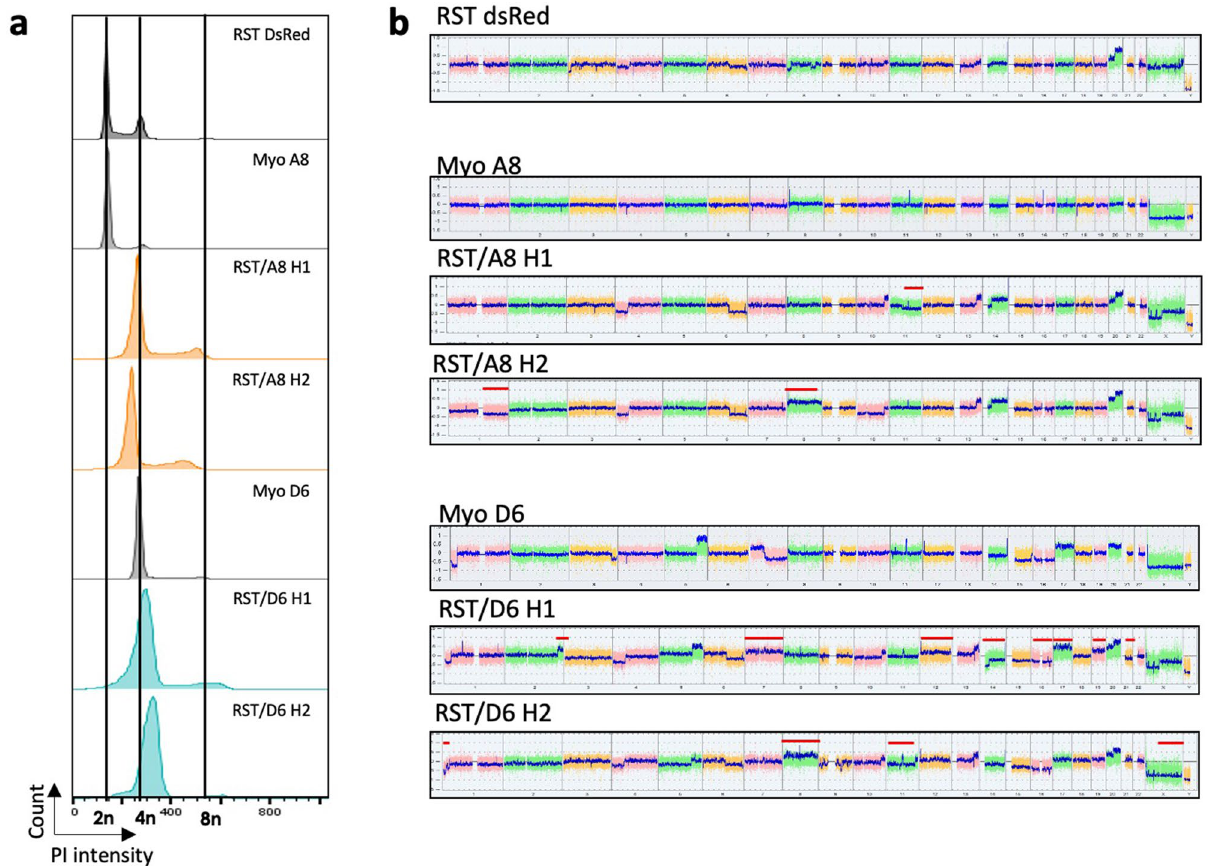
cells and RST/D6 hybrids are pentaploid as compared to diploid RST DsRed and tetraploid Myo D6 parental cells. Vertical lines indicate 2n, 4n and 8n ploidies. ( b ) Genomic profiling of RST DsRed, myoblast and hybrids cell lines analysed using the Chromosome Analysis Suite software v3.1. Copy number variations (CNVs) demonstrate that hybrid genome is rearranged upon fusion. x axis: chromosome 1 to chromosome Y; y axis: log2 ratio. Post-fusion new genomics alterations are indicated by red